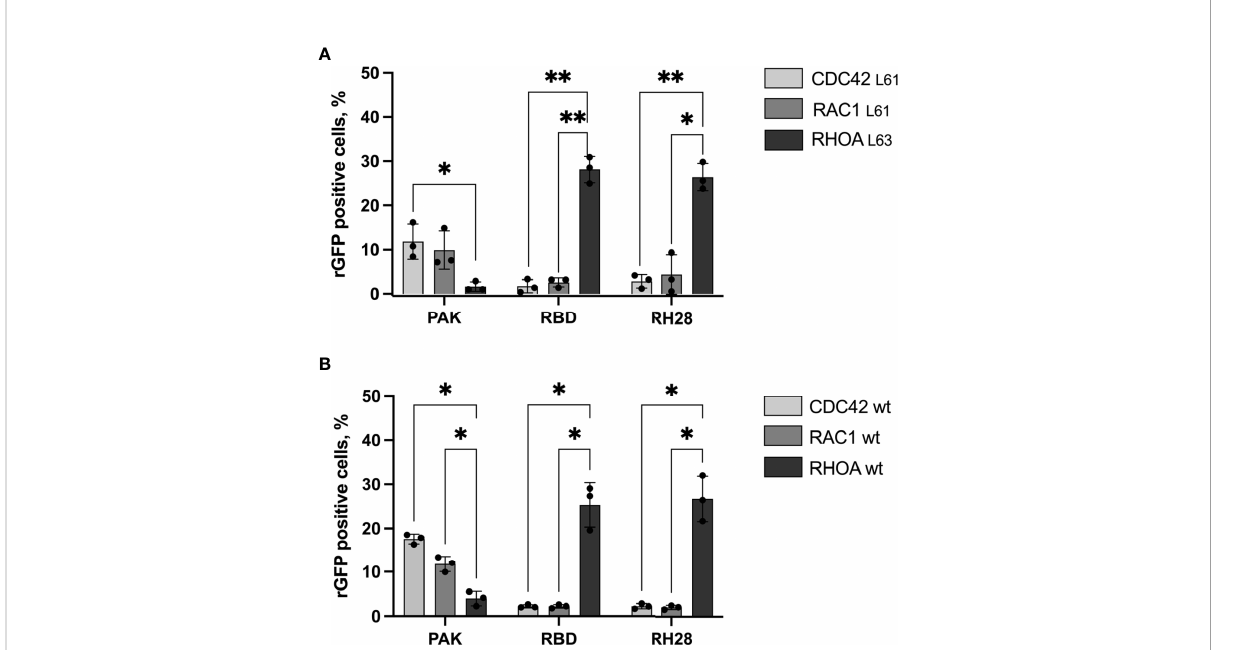
FIGURE 2 The RH28 is selective for active RHOA conformation in living cells. Percentage of reconstituted GFP (rGFP) fl uorescent cells analyzed by fl ow cytometry for the indicated transfection conditions. (A) constitutively active mutants (B) wild-type proteins. P-values were calculated using a Student ’ s t test.*p<0.05;